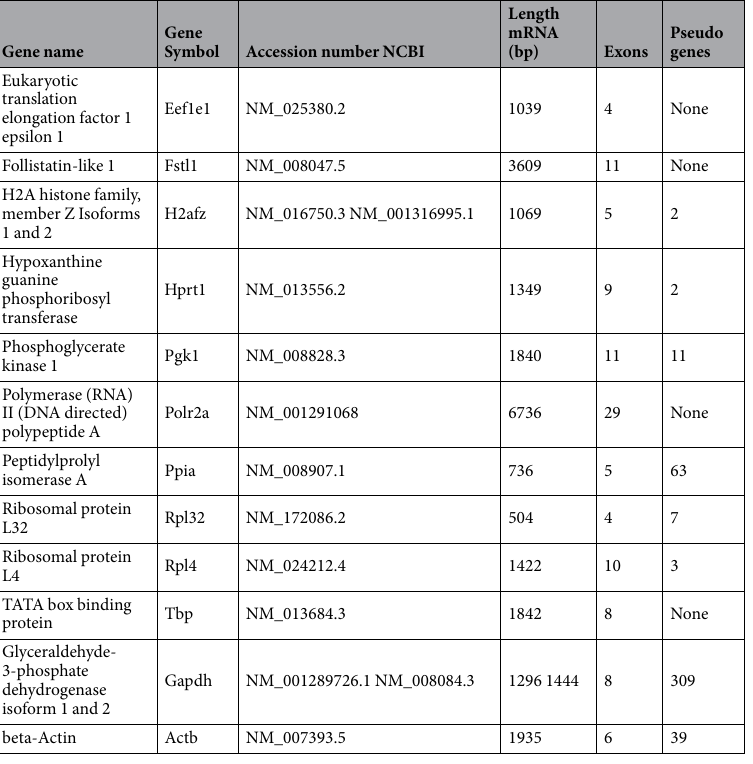
Table 2. Gene information.